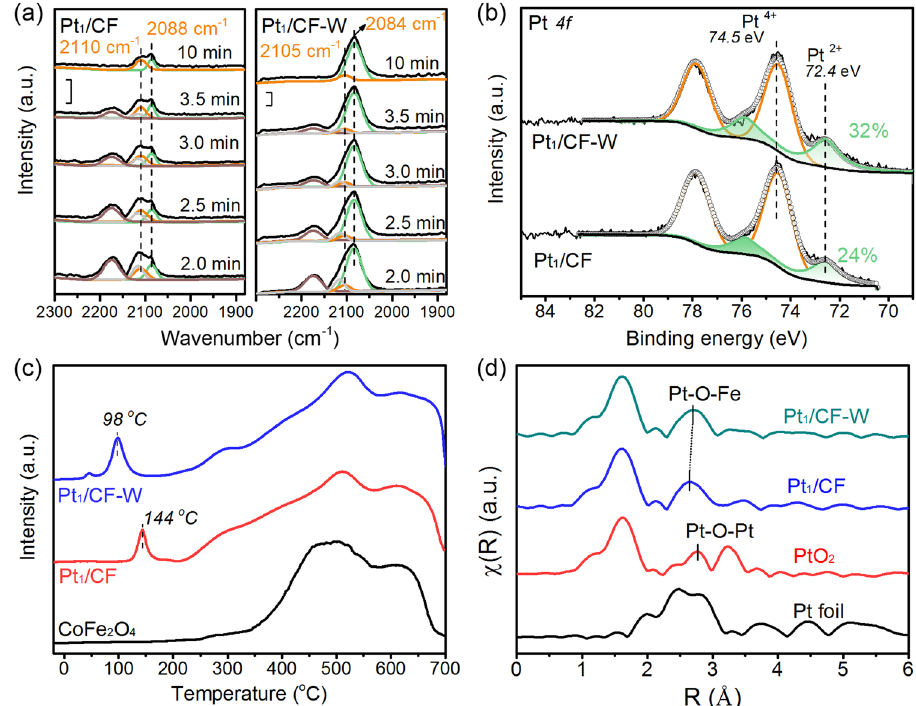
Fig. 2 The MSI of Pt 1 /CF and Pt 1 /CF-W. a Time-resolved CO-DRIFT spectra of Pt 1 /CF and Pt 1 /CF-W when purging the CO with He. b Pt 4 f XPS